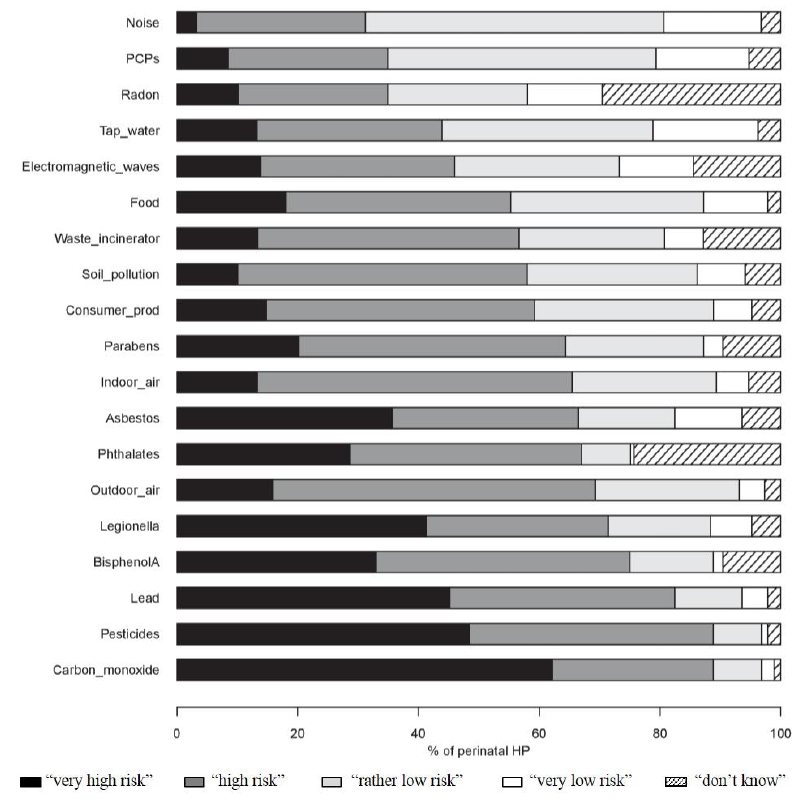
Figure 2. Perception of perinatal HPs of the risk of pregnant women and their unborn baby related to exposure to 19 environmental factors ( n = 189). Consumer_prod, consumer products (corresponds to household, do-it-yourself (DIY) and gardening products); HP, health professionals; PCPs, personal care products.